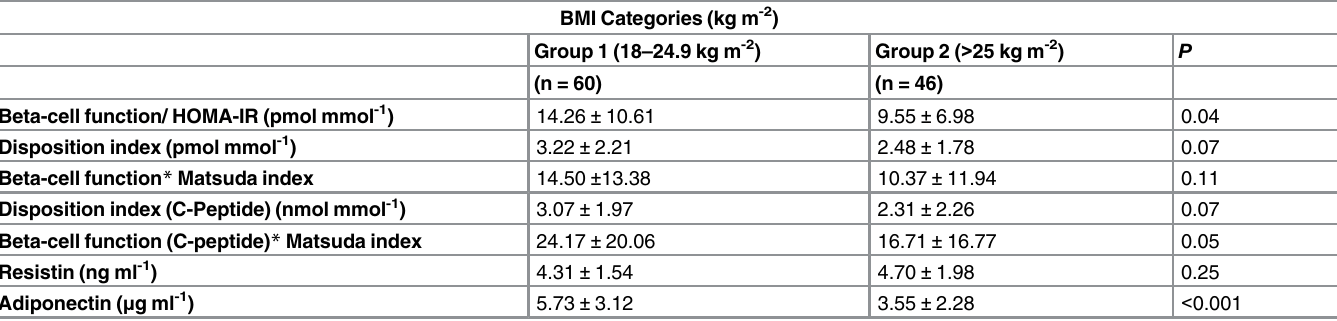
Table 2. Beta-cell function, resistin and adiponectin according to BMI